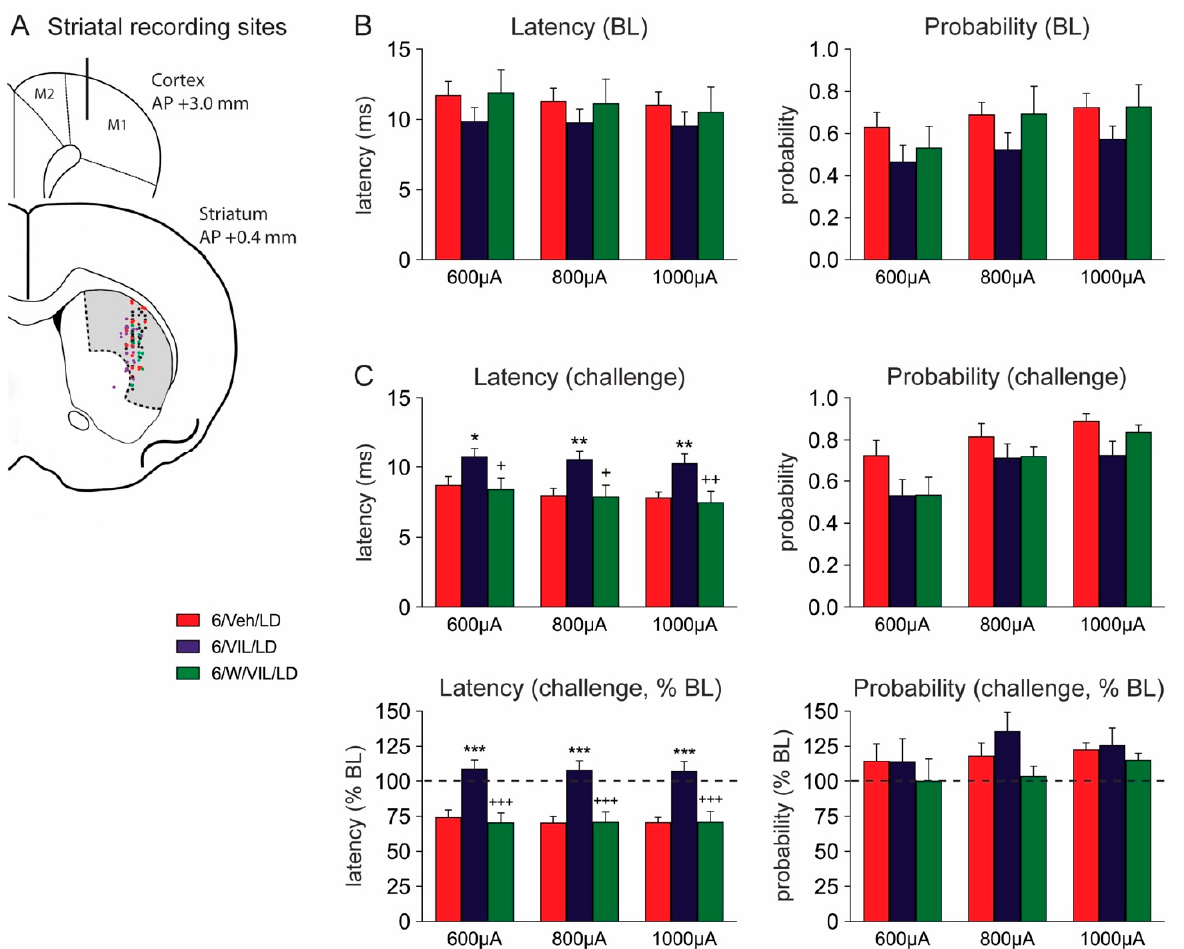
Figure 4. Vilazodone inhibits L-DOPA effects on spike onset latency after cortical stimulation in striatal MSNs, and this inhibition is mediated by 5-HTr 1A stimulation. ( A ) Schematic illustration of coronal sections through the frontal cortex and middle striatum (approximately at +3.0 and +0.4 mm rostral to bregma) showing the stimulation site in the primary motor cortex (M1), and, collapsed onto one level, the distribution of recording sites in the sensorimotor striatum (shaded) for the different treatment groups (“challenge” units: 6/Veh/LD, red dots; 6/VIL/LD, purple dots; 6/W/VIL/LD, green dots; pooled “baseline” units, black dots). ( B ) Cortically evoked responses in MSNs of 6-OHDA-lesioned rats recorded before the final drug treatment (“baseline” responses, BL). Displayed are spike onset latency (mean ± SEM) (left) and spike probability (right) in rats that had received a repeated pretreatment with vehicle + L-DOPA (5 mg/kg, i.p.) (6/Veh/LD; n = 11 cells in 5 rats), vilazodone (10 mg/kg, i.p.) + L-DOPA (6/VIL/LD; n = 14 cells in 8 rats), or WAY-100635 (0.5 mg/kg, i.p.) + vilazodone + L-DOPA (6/W/VIL/LD; n = 7 cells in 3 rats). ( C ) Cortically evoked responses in MSNs of 6-OHDA-lesioned rats recorded after the final drug treatment (“challenge” responses, top). Shown are spike onset latency (left) and spike probability (right) in rats that had received a repeated treatment with vehicle + L-DOPA (5 mg/kg, i.p.) (6/Veh/LD; n = 21 cells in 8 rats), vilazodone (10 mg/kg, i.p.) + L-DOPA (6/VIL/LD; n = 19 cells in 9 rats), or WAY-100635 (0.5 mg/kg, i.p.) + vilazodone + L-DOPA (6/W/VIL/LD; n = 16 cells in 7 rats). Additionally displayed are these data expressed in percentage of baseline values (% BL) (bottom). Vilazodone co-administered with L-DOPA (6/VIL/LD) prevented the L-DOPA-induced decrease in onset latency (6/Veh/LD). WAY administration (6/W/VIL/LD) blocked vilazodone’s ability to attenuate the L-DOPA effect on the onset latency. * p < 0.05, ** p < 0.01, *** p < 0.001, vs. 6/Veh/LD; + p < 0.05, ++ p < 0.01, +++ p < 0.001, vs. 6/VIL/LD.